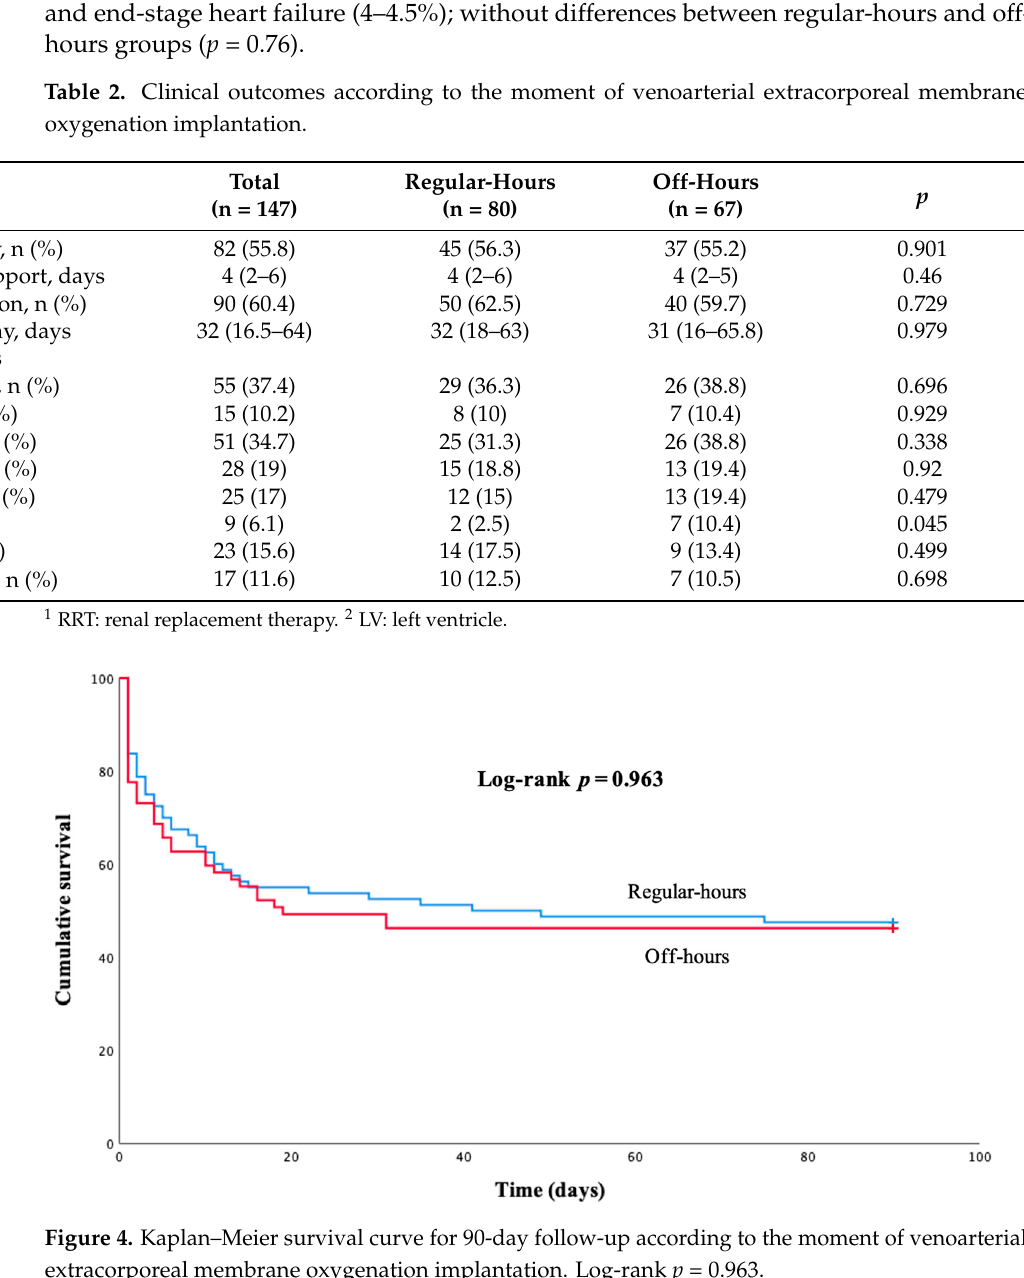
(Figure 4). The results were similar irrespective of VA-ECMO indications (Table S1) and type of left ventricular unloading device (Table S2). Most frequent causes of death were